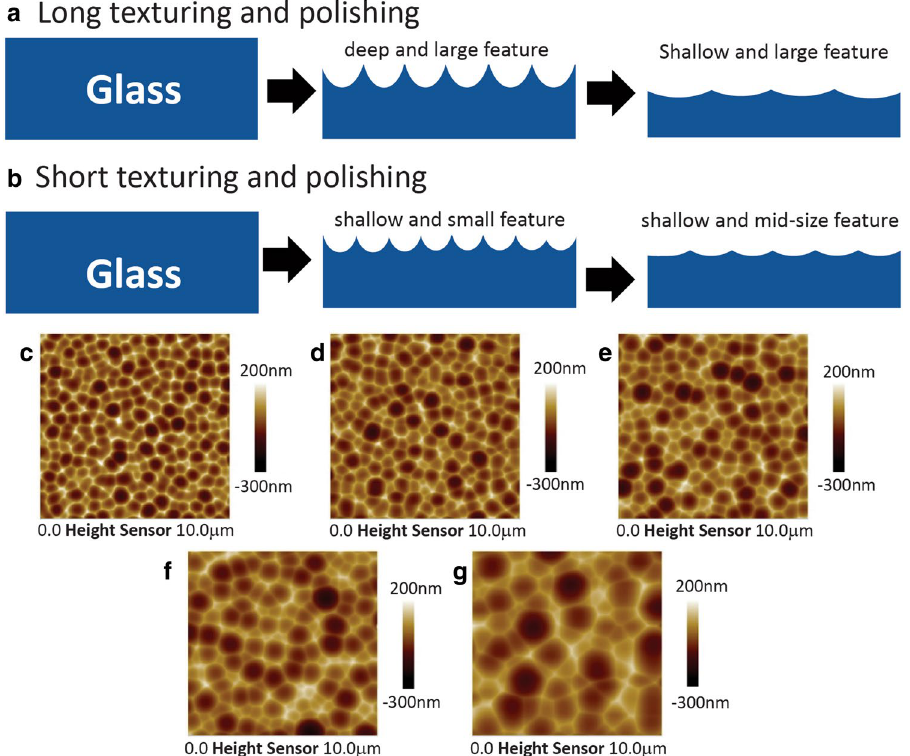
Figure 4. Mechanism of texturing and chemical polishing of silicate glass to tune surface feature size and depth. In this process, the texturing step increases both surface size and feature depth or roughness. The following polishing step grows feature size but reduces texture depth or roughness. ( a ) Generate shallow and large features on glass by long texturing and long chemically polishing. During the texturing process, long treatment results in deep and large features. Prolonged chemical polishing creates shallow and large feature. ( b ) Generate shallow and mid-size features on glass by short texturing and short chemically polishing. During the texturing process, short treatment results in shallow and small features. Brief chemical polishing keeps the surface features small and shallow. ( c )–( g ) Examples of texture surfaces at haze level but with different surface feature sizes fabricated through texturing and chemical polishing process (Condition A1–A5 in Table 1). By gradually increasing the leaching time and polishing time, the average feature size increases significantly from 0.9 to 2.3